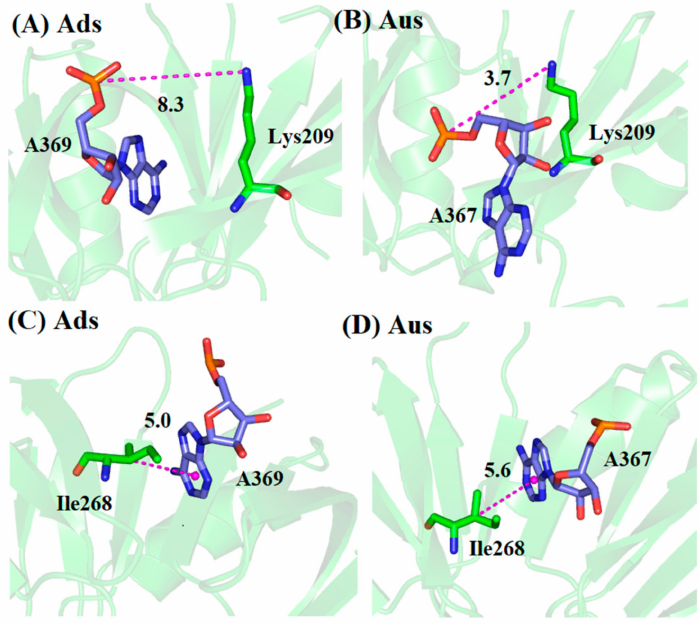
Figure 3. The conformations in the lowest-energy structures of MD trajectory for key residues Lys209 and Ile268. ( A ) Lys209 in Ads system. ( B ) Lys209 in Aus system. ( C ) Ile268 in Ads system. ( D ) Ile268 in Aus